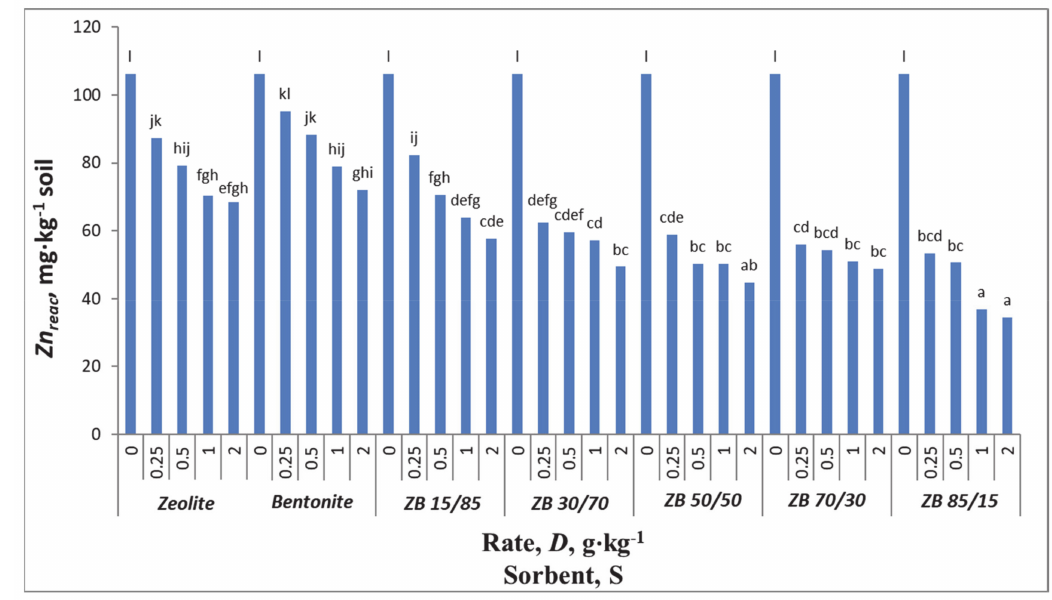
Figure 3. Content of the reactive zinc fraction ( Zn reac ) on the background of interactions sorbent ( S ) and rates ( D ). Small letters a to l refer to statistical differences among the tested treatments, the same letter means no significant differentiation.